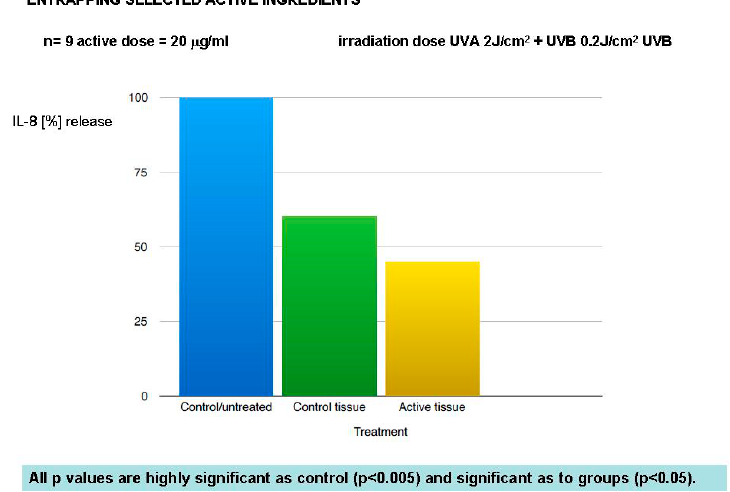
Figure 3. Anti-inflammatory effectiveness of the mask verified on the IL-8 release.